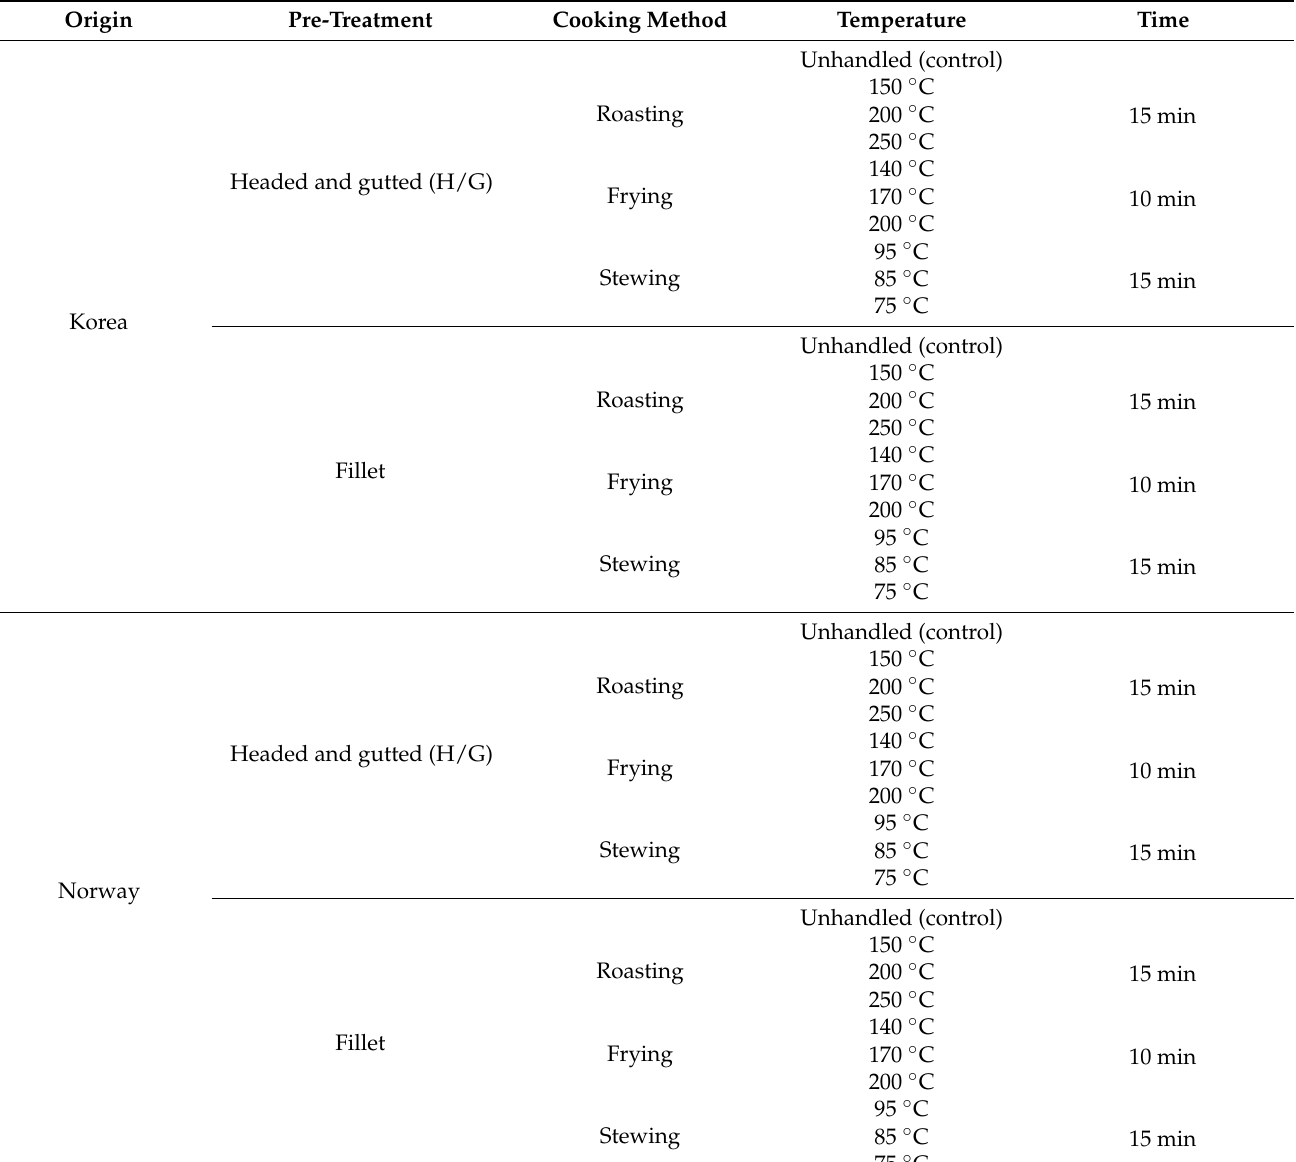
Table 1. Preparation of 40 mackerel